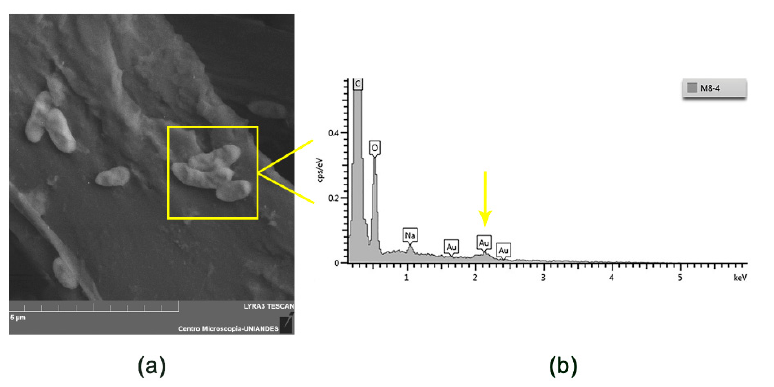
Figure 5. SEM micrographs of L. sphaericus CBAM5 cells ( a ) attached to a PCL microfiber seen with retro-dispersed electrons. ( b ) EDS analysis of image (a) showing the presence of Au in the cells.